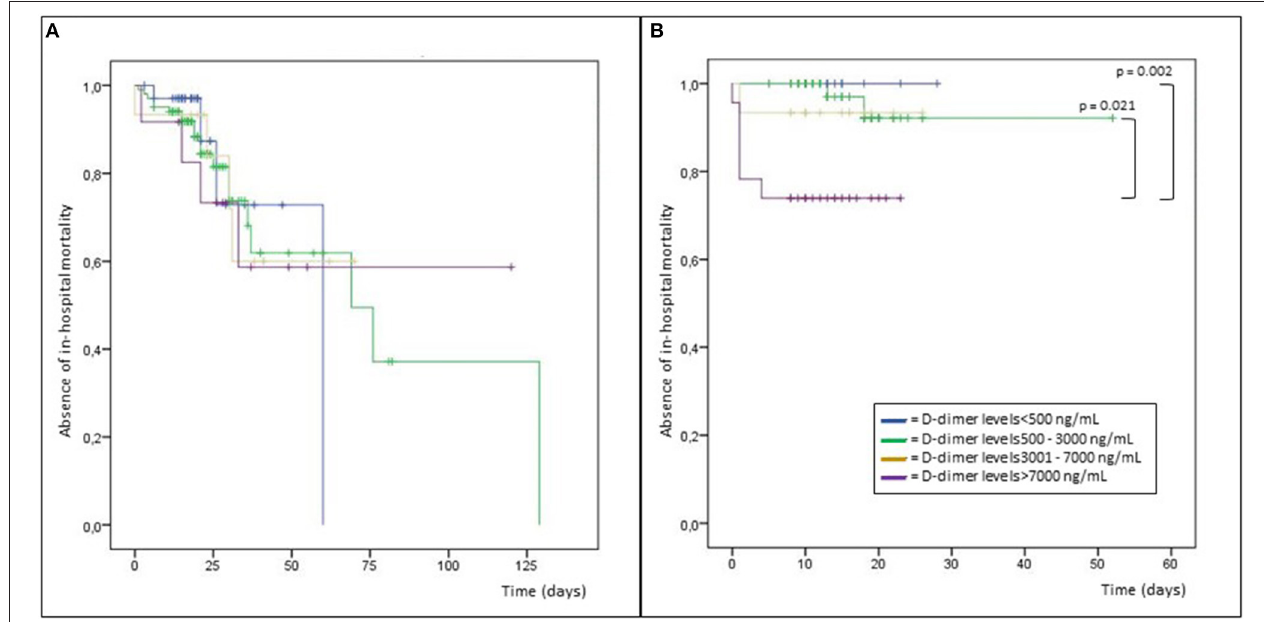
FIGURE 1 | Kaplan-Meier analysis of in-hospital mortality in patients with infections due to Streptococcus pneumoniae (A) and Neisseria meningitidis (B) .